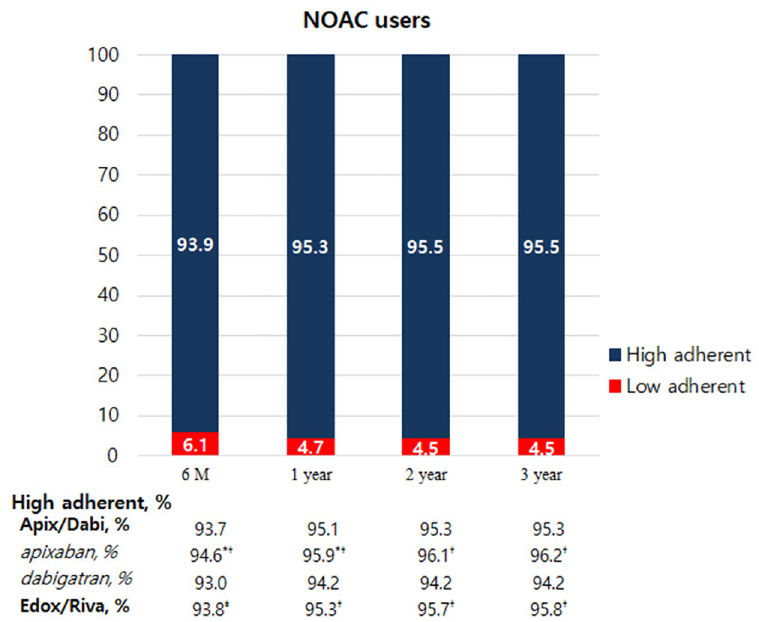
Fig 2. Time-specific proportions of high and low adherence patients for NOACs. NOAC, non-vitamin K antagonist oral anticoagulant; M, month; Y, year; Apix/Dabi, apixaban or dabigatran; Edox/Riva, edoxaban or rivaroxaban; * p value < 0.05 compared with Edox/Riva users; † p value < 0.001 compared with dabigatran users; ‡ p value < 0.05 compared with dabigatran users.